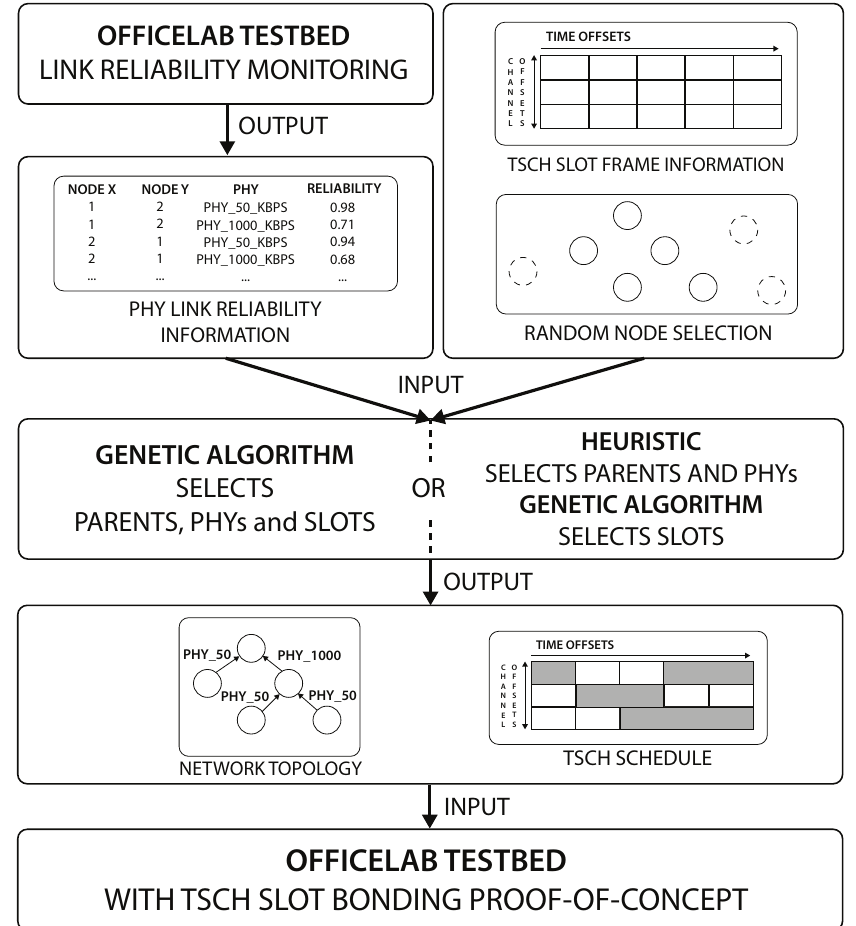
Figure 7. Flow diagram illustrating the testbed evaluation process. The testbed link monitoring information was used as input for the heuristic (with the GA for slot allocations) or the GA, and the outcomes of those schedulers were loaded on the sensor nodes in the